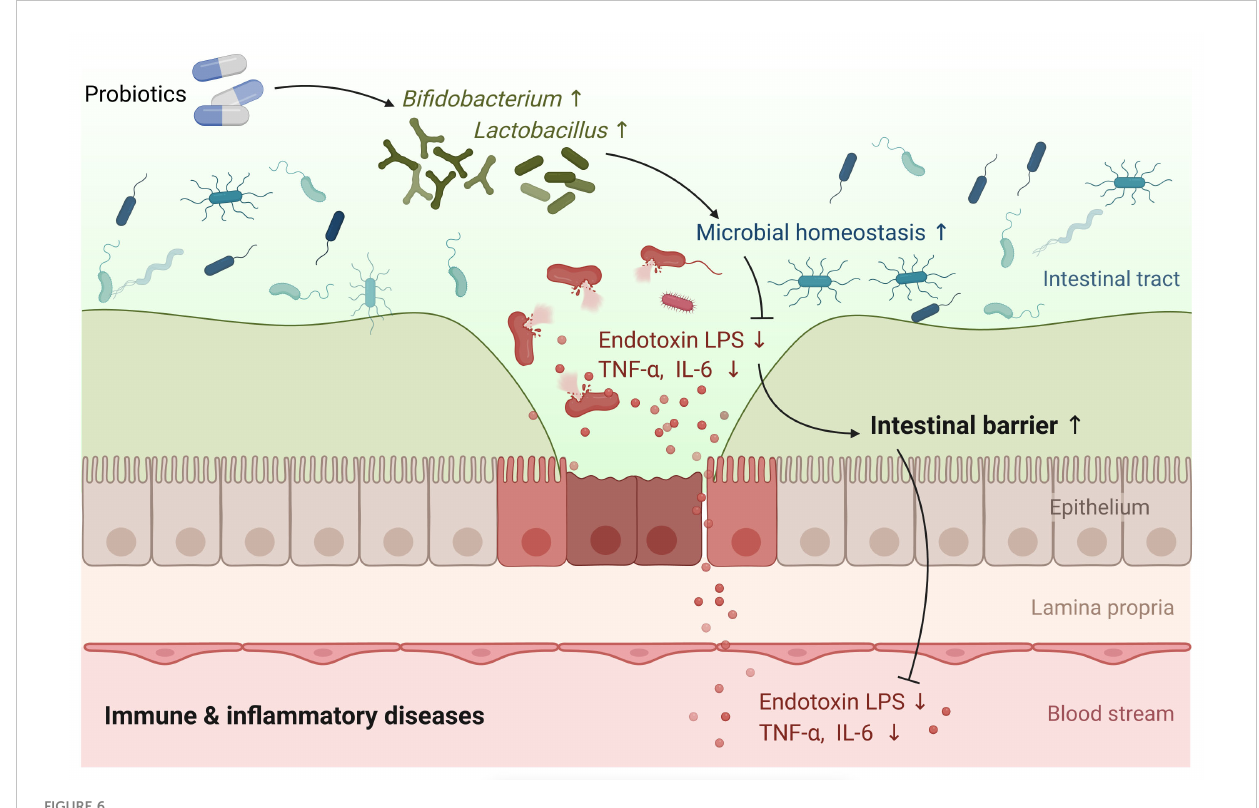
FIGURE 6 Graphical illustration describes the effect of probiotics in fortifying the intestinal barrier function in immune and in fl ammation